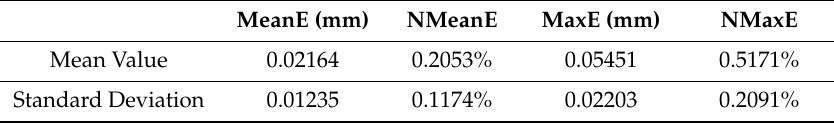
Table 3. Performance measures for the prediction of TAV deformed shapes ( ρ =